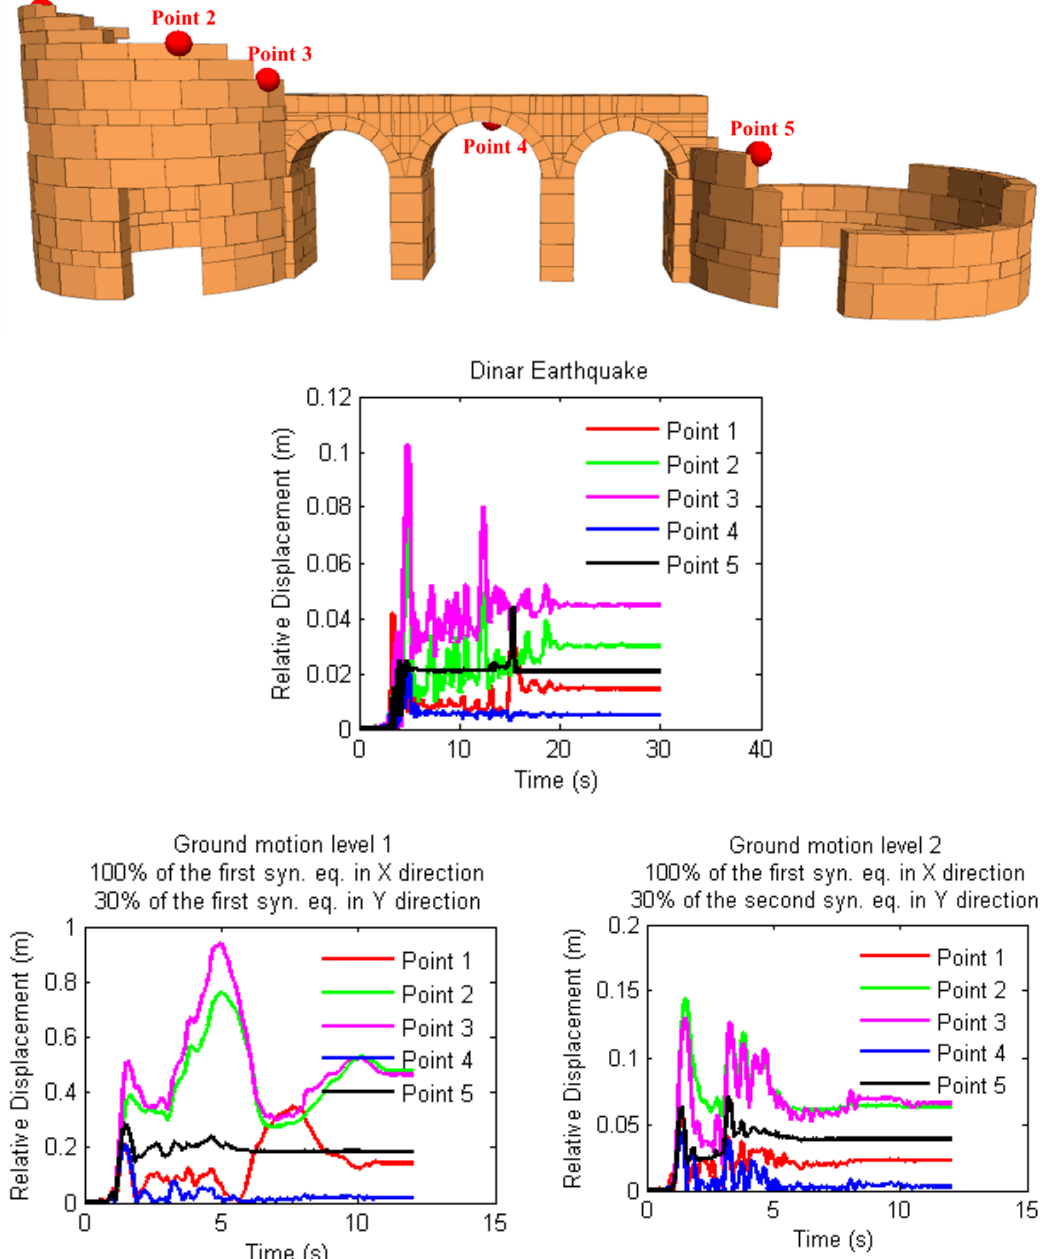
Figure 15. Time histories of displacements relative to the base under the Dinar, Turkey 1995 earthquake and the synthetic earthquakes.